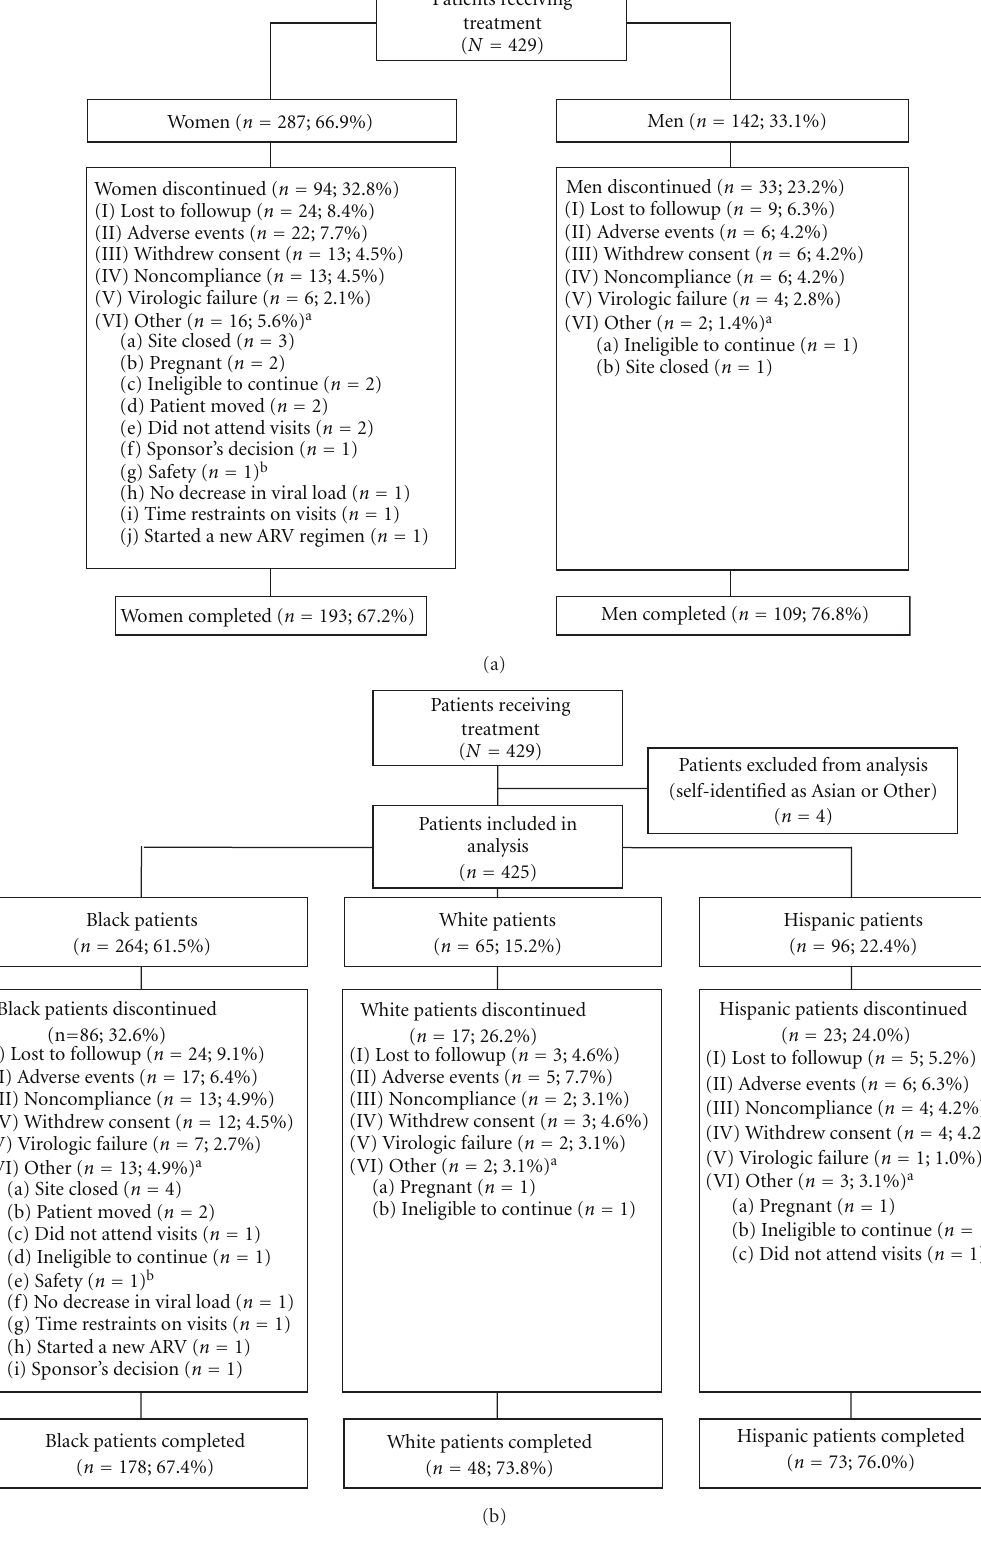
Figure 1: Study disposition by (a) sex and (b) race. a “Other” classification was selected by the investigator as reason for discontinuation. b Older patient taking too many concomitant medications; ARV: